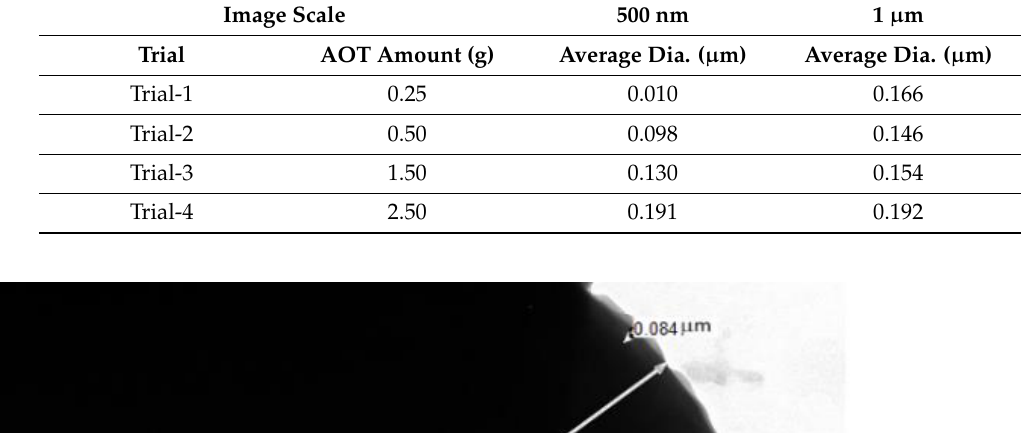
Table 3. Microcapsule average shell thicknesses for all trials at different image scales. Image Scale 500 nm Trial